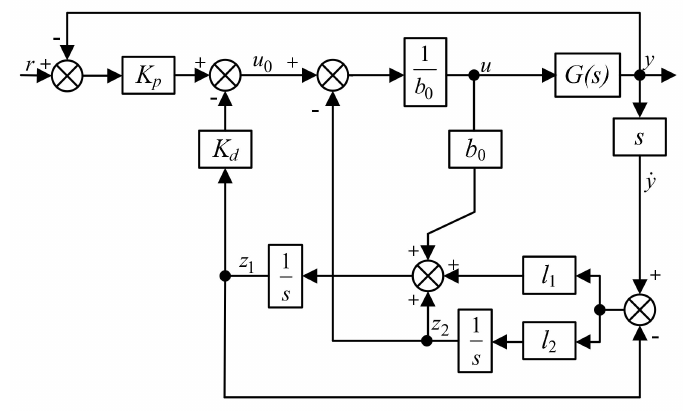
Figure 6. Structure diagram of LADRC based on